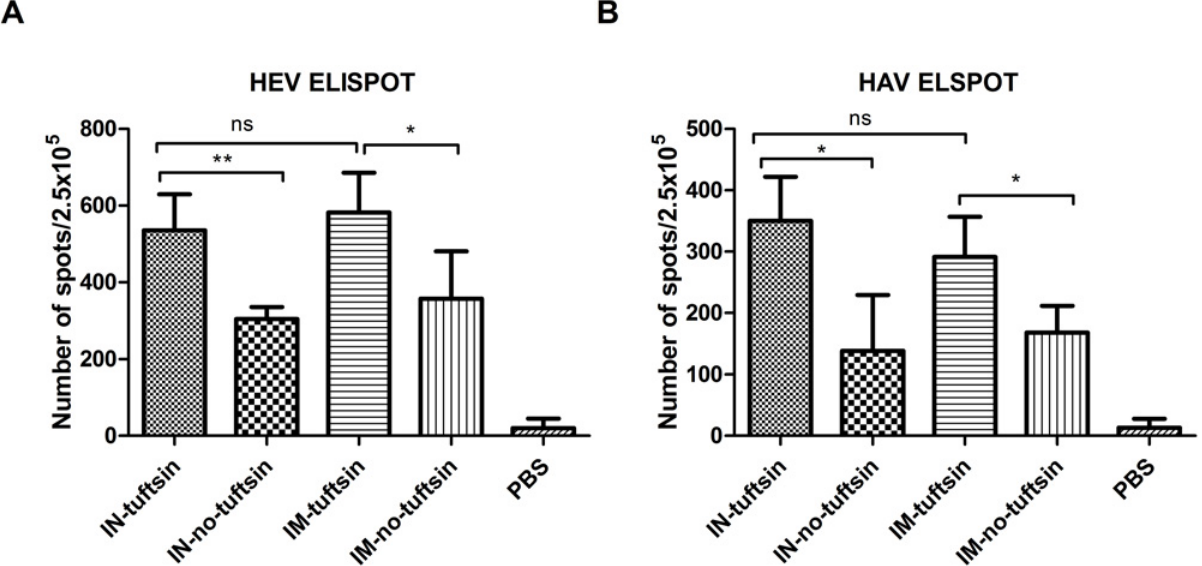
Fig 5. ELISPOT detection of in vitro IFN- γ production by splenocytes of vaccinated mice. Splenocytes from two spleens were pooled for a total of three samples per immunization group and analyzed by ELISPOT. (A) Numbers of spleen cells targeting HEV and (B) numbers of spleen cells targeting HAV were detected in the mouse groups immunized as indicated in Fig 2. Error bars represent the SEM. * , P < 0.05, ** , P < 0.01, *** , P < 0.001; ns, no significant difference.